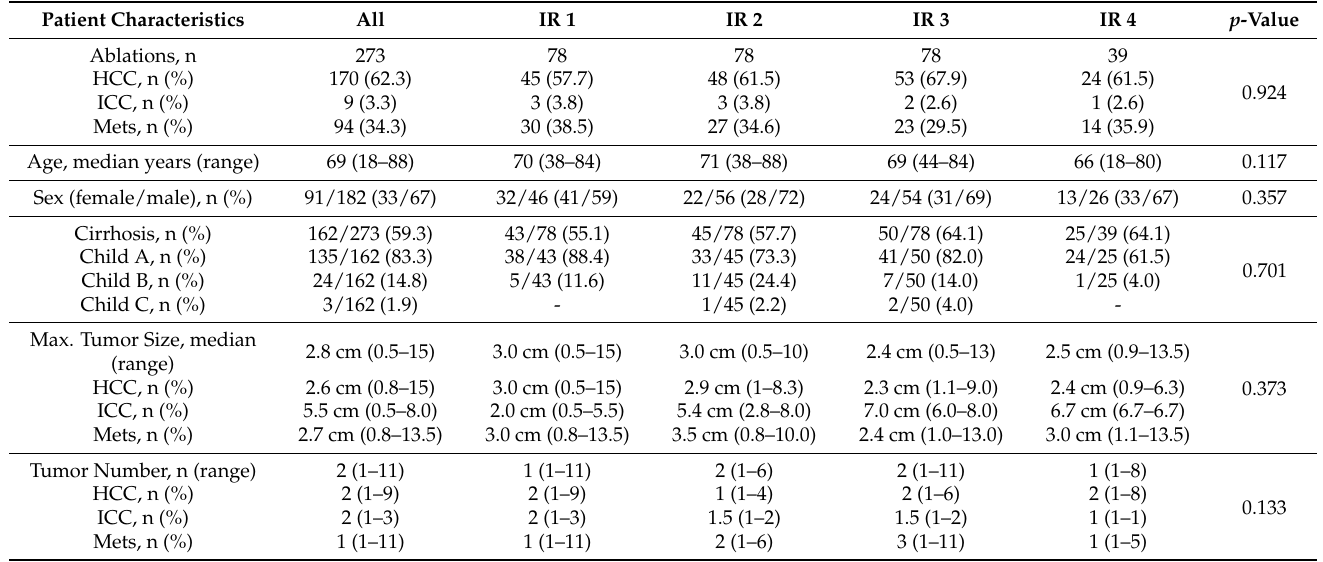
Table 1. Patient characteristics of 237 patients undergoing 273 SRFAs of primary and metastatic liver tumors, grouped by interventional